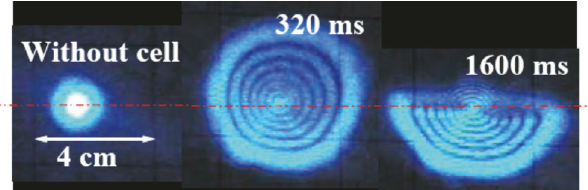
fixed points on the z axis (1–4) in the range of z = (0 ÷± 25.5)